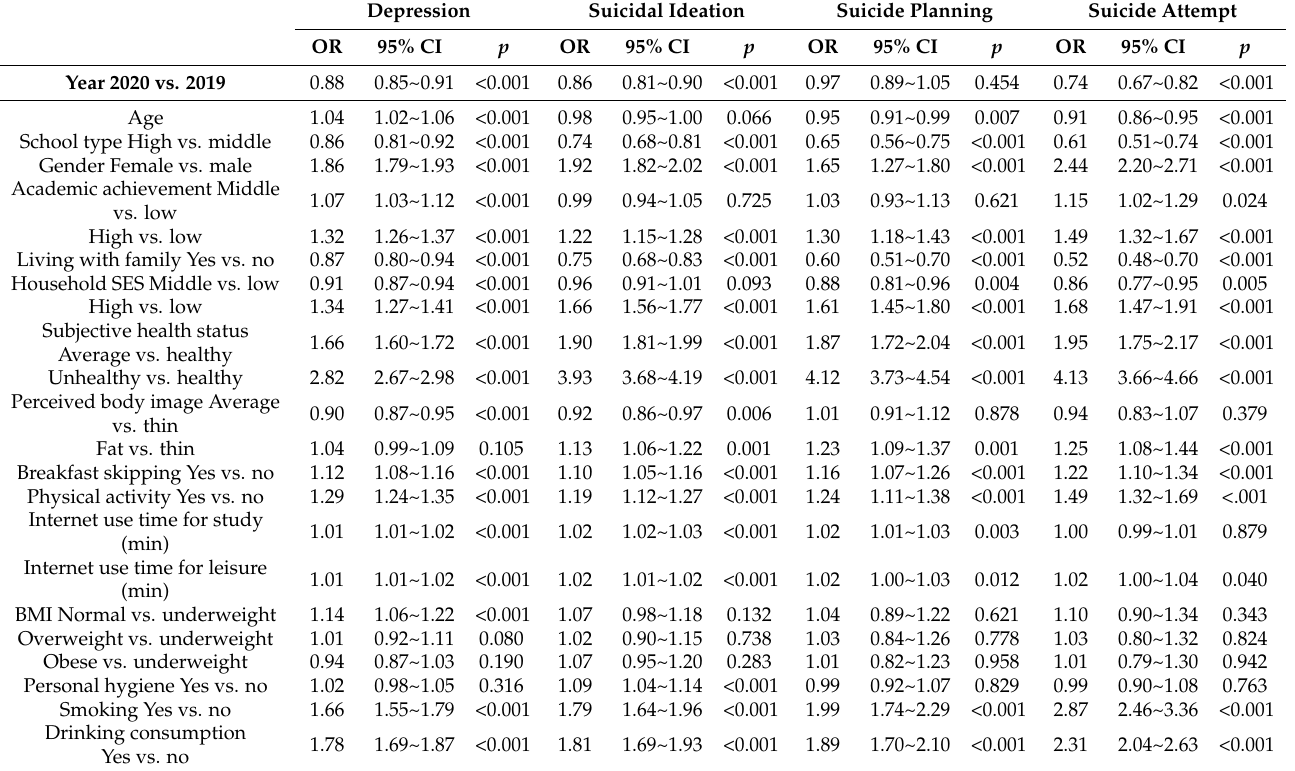
Table 4. Changes between 2019 and 2020 in the relationships of the general and health related characteristics with the suicide-related